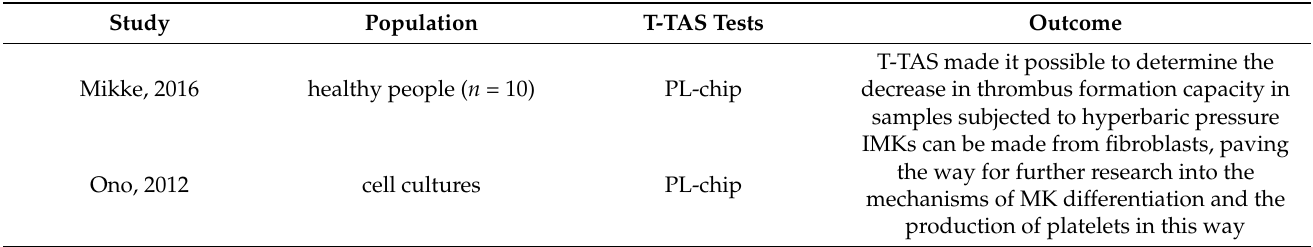
T-TAS made it possible to determine the decrease in thrombus formation capacity in samples subjected to hyperbaric pressure